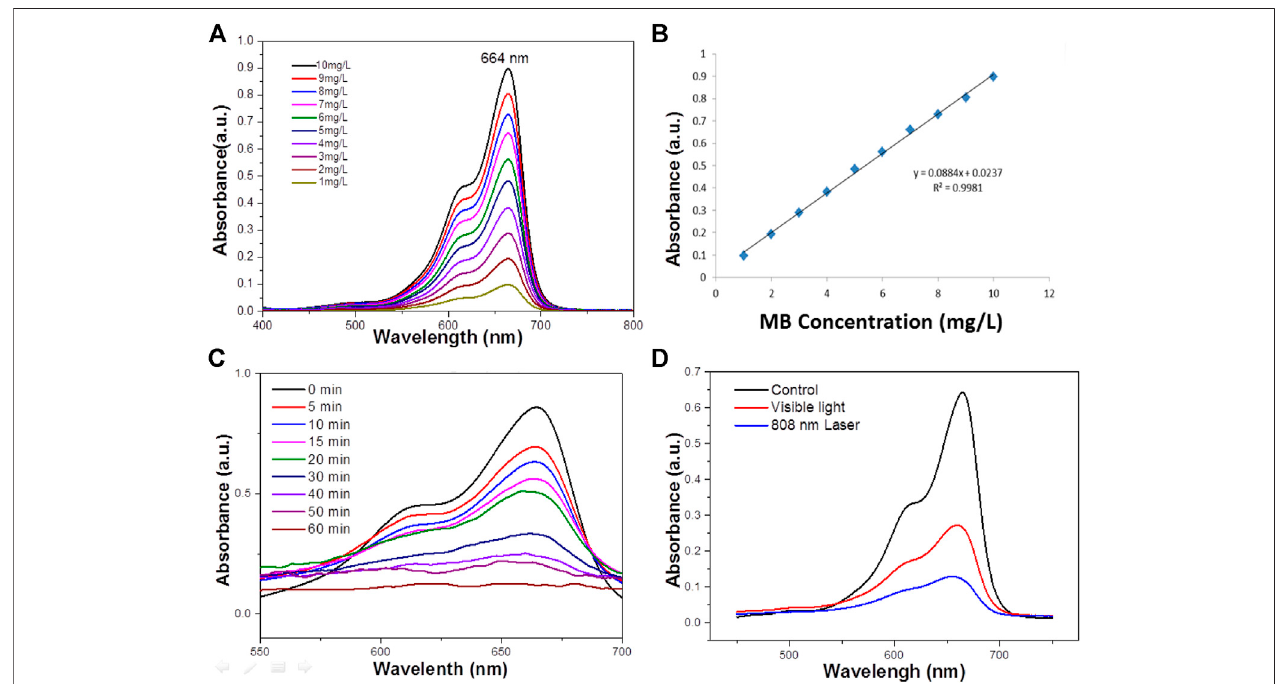
FIGURE 3 | (A) The absorbance spectra of MB standard solutions of different concentrations. (B) The Absorbance-concentration fi tting curve of MB solution. (C) UV – vis absorbance spectrum for the aqueous dispersion of the WO 3 NPS under NIR light (concentration 100 ppm). (D) The photodegradation pro fi le of MB in the presence of the WO 3 nanocatalyst under exposure to visible light and 808 nm laser irradiation (concentration 100 ppm).